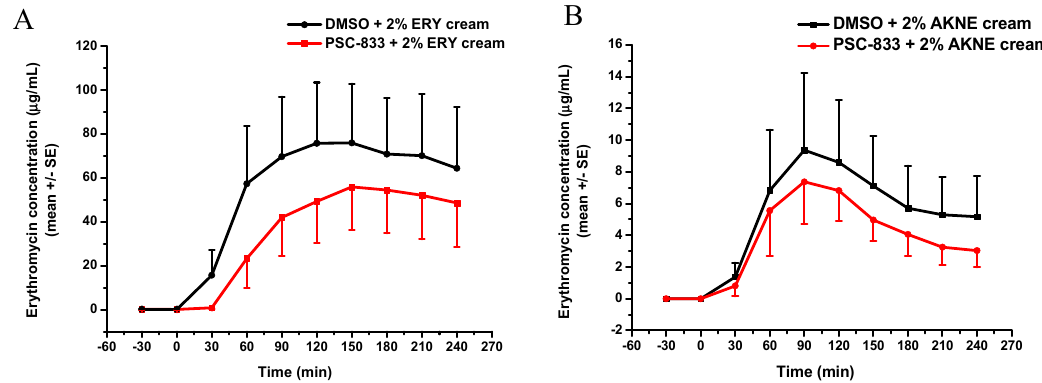
Figure 8. Concentration-time profiles of the absorption of topical erythromycin cream (ERY) or Aknemycin ® cream measured by transdermal microdialysis in vivo in anesthetized rats. (Panel A ) 2% ERY paraffin-based cream, (Panel B ) AKNE: 2% erythromycin containing Aknemycin ® cream. n = 5/group.